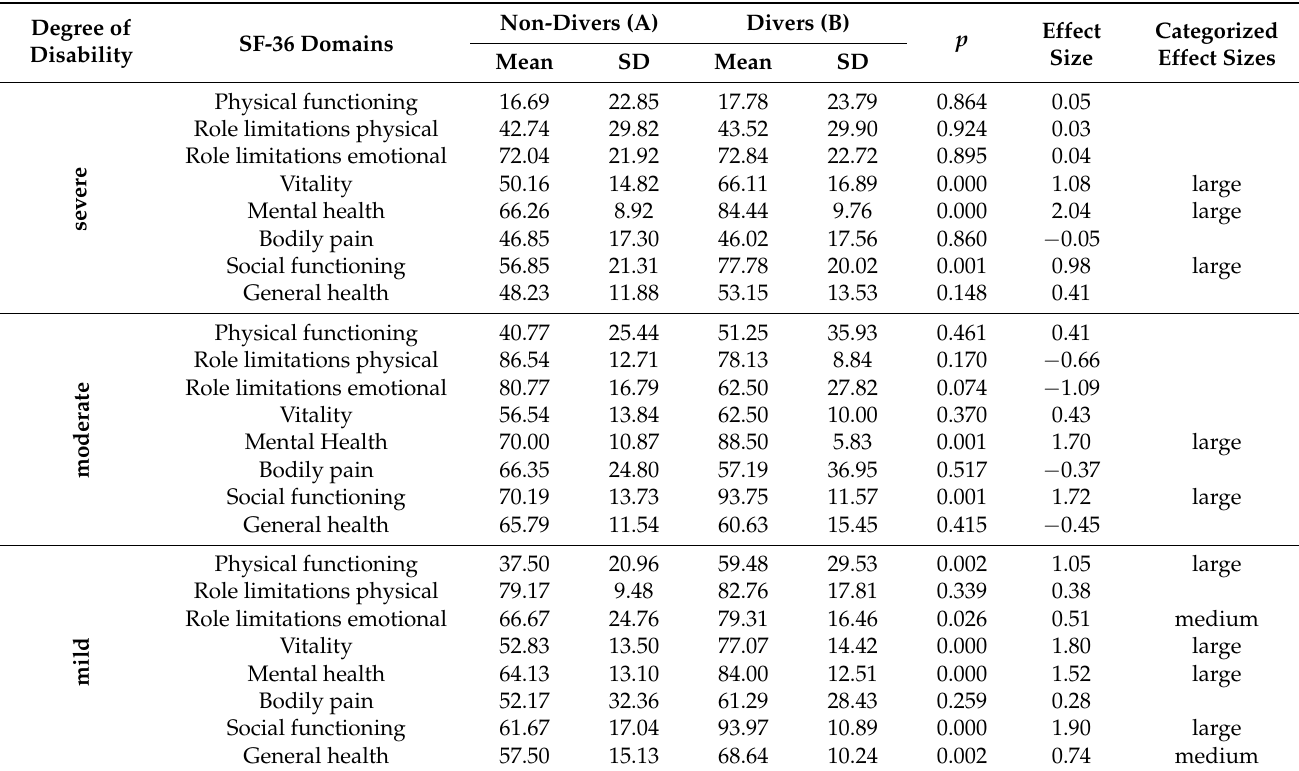
Table 3. Comparison of SF-36 domains between diving and non-diving people with disabilities depend on degrees of disability (post hoc Tukey test).